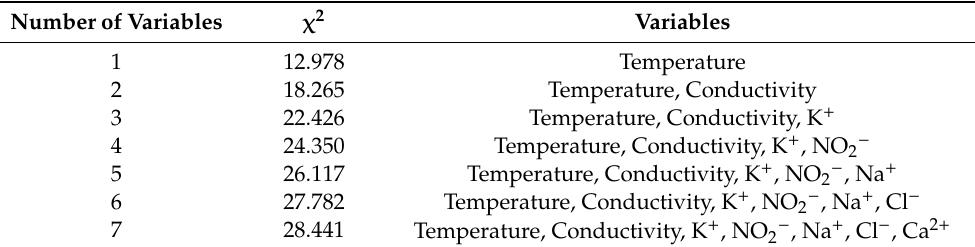
Table 5. Best subset of physico-chemical data for predicting presence of copepods for each of k = 1, ... 7 explanatory variables using logistic regression. The six variable model was chosen for further analysis because addition of an additional variable added less than one to the χ 2 value.